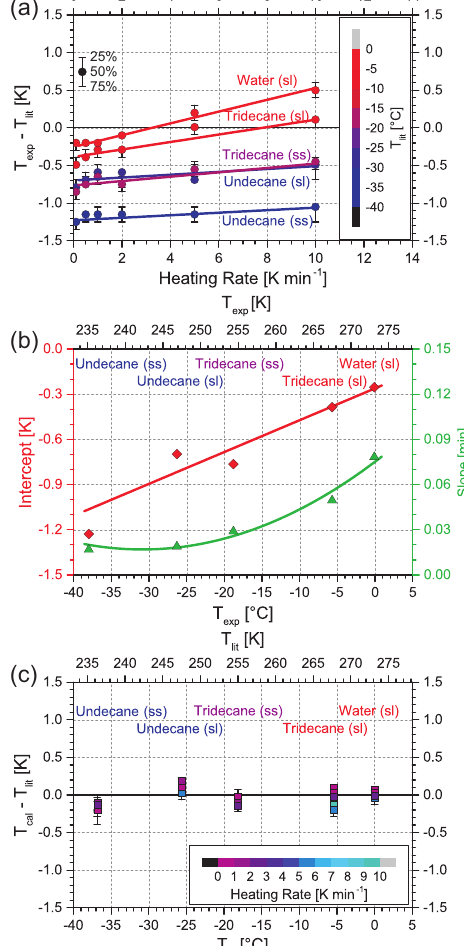
Figure 3. Temperature calibration. (a) Difference between the ex- perimentally determined phase transition temperatures of water, tridecane and undecane droplets and the corresponding literature values as a function of heating rate. Linear fits to the data are indi- cated by the solid lines. (b) Intercepts (left, red) and slopes (right, green) of the linear fits shown in (a) above. The experimentally de- termined data (symbols) are fitted by a linear function (intercepts, red line) and by a second-order polynomial (slopes, green line). (c) Residual difference between the calibrated phase transition tem- peratures and the literature values after